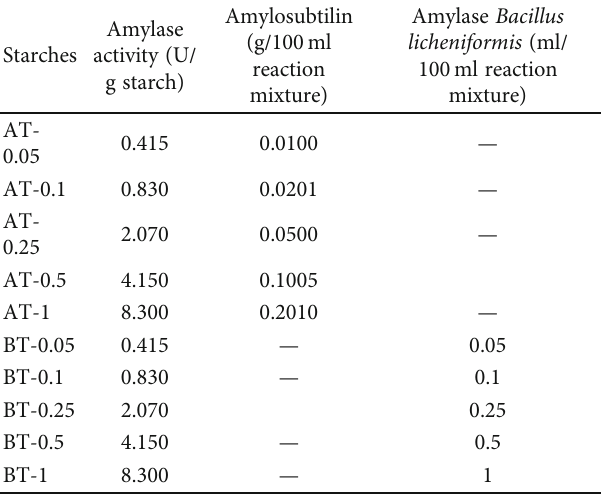
Table 1: Code of fermented modi fi ed starches. Amylase Starches activity (U/ g